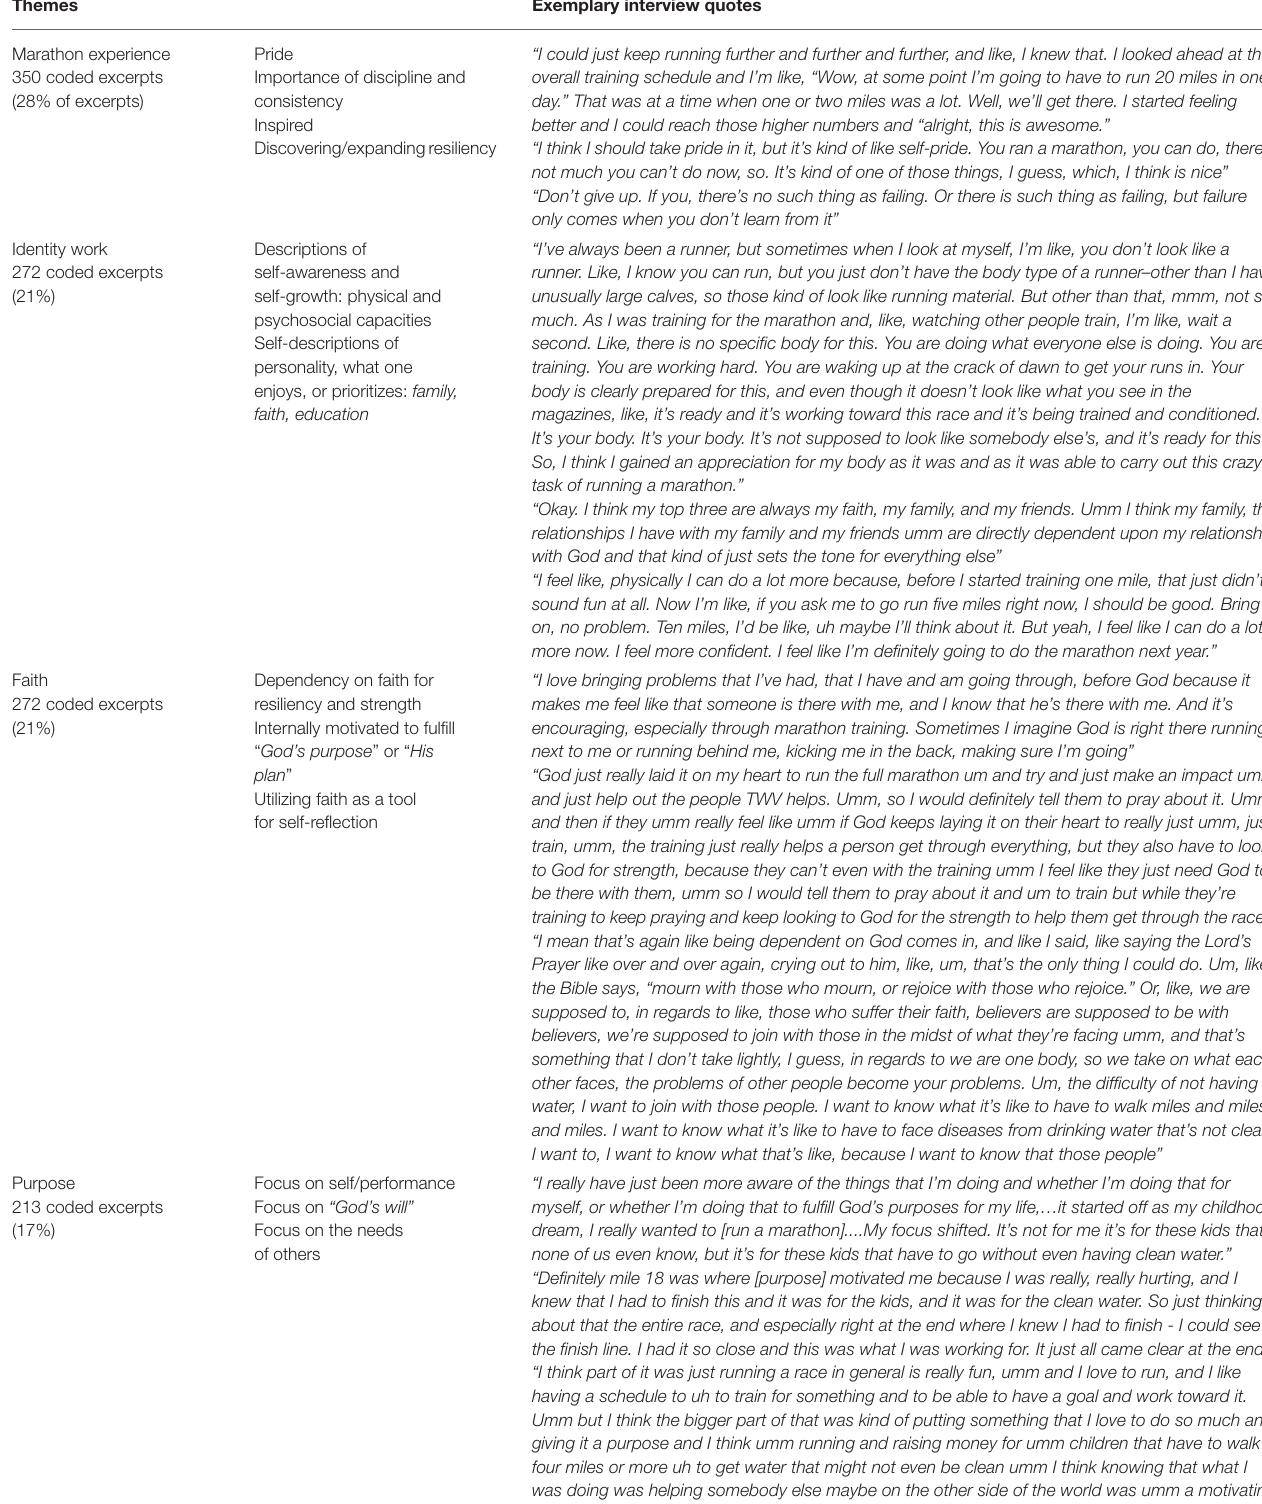
TABLE 1 | Thematic categories summarized. Themes Exemplary interview